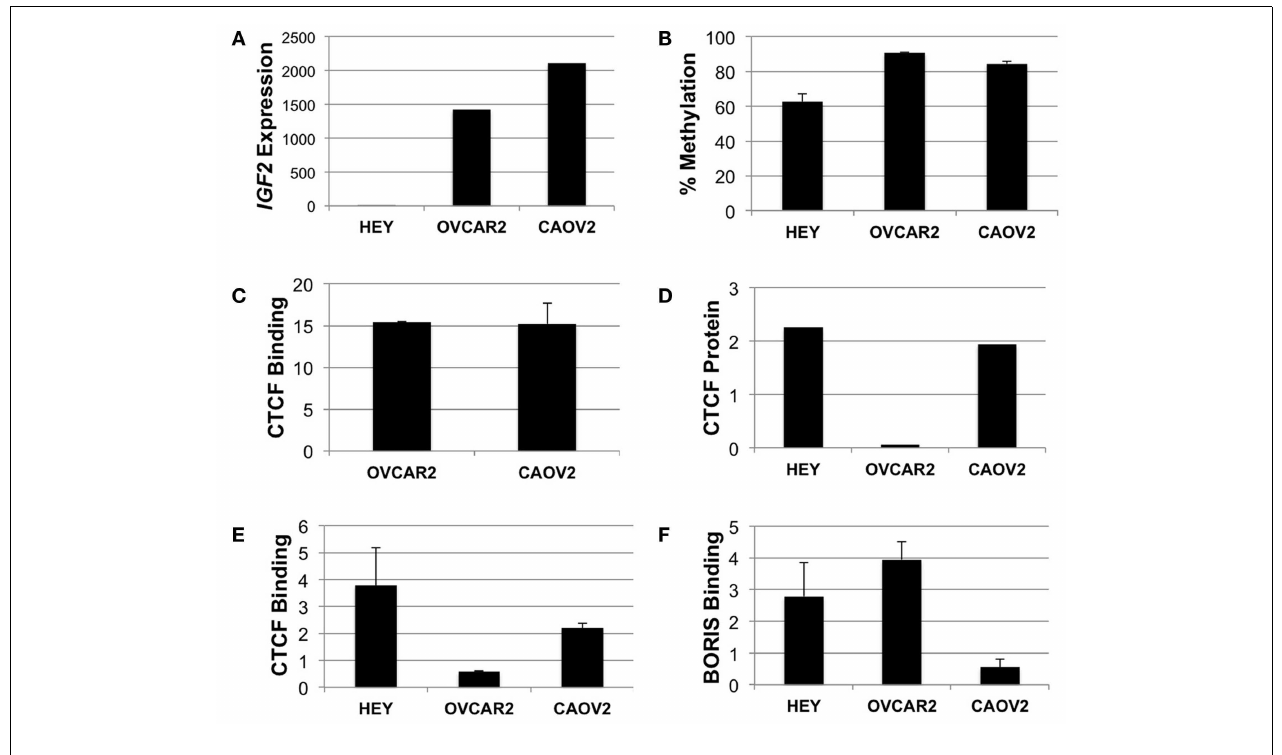
analyzed); (D) Western blot detection of CTCF protein levels; (E) ChIP assay for binding of CTCF to the IGF2 intron 3 CTCF binding motif; (F) ChIP assay for binding of BORIS to the IGF2 intron 3 CTCF binding